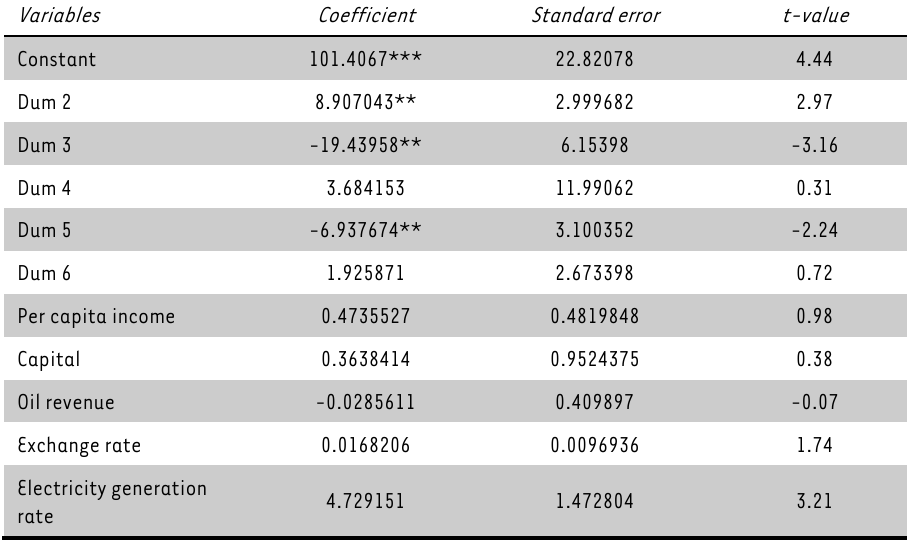
Table 4: Fixed effects (LSDV) estimation results for manufacturing sector growth rate